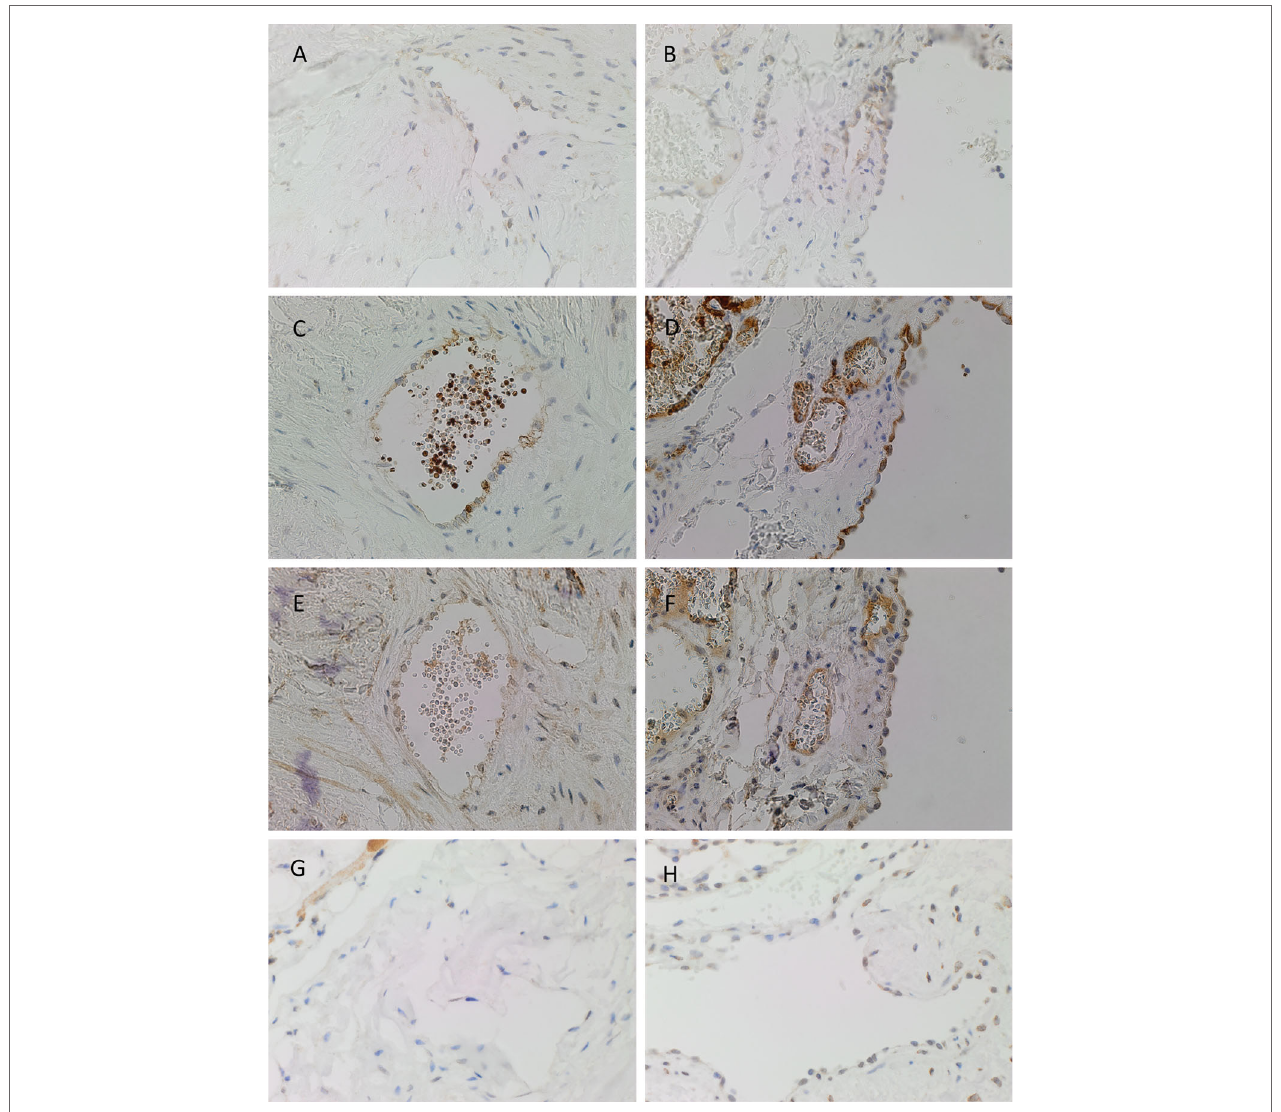
FigUre 2 | representative DaB ihc-stained sections of iM [(a,c,e,g), brown] and sc [(B,D,F,g), brown] VM demonstrating the expression of Prr in iM [(a), brown] and sc [(B), brown] lesions . ACE was also expressed on the endothelium of IM [ (c) , brown] and SC [ (D) , brown] lesions. ATIIR1 was expressed in both IM [ (e) , brown] and SC [ (F) , brown] lesions. Faint staining of ATIIR2 was seen on the endothelium of IM [ (g) , brown] and SC [ (h) , brown] VM. Original magnification: 400 × . FigUre 3 | aTiir1 was expressed to a greater degree in the smaller lesional vessels [(a,B), brown, thin arrow ], compared with the adjacent dilated lesional vessels [(a,B), brown, thick arrow ] in both iM (a) and sc (B) VM . Original magnification: 400 × .